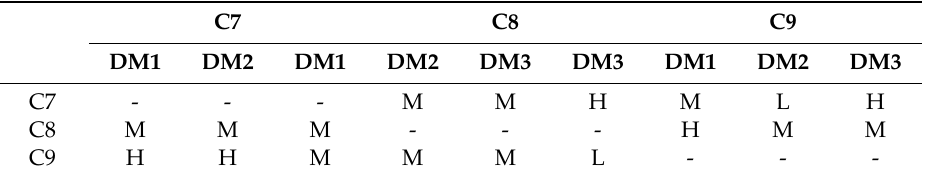
Table A4. Linguistic evaluations of the criteria for dimension 3.